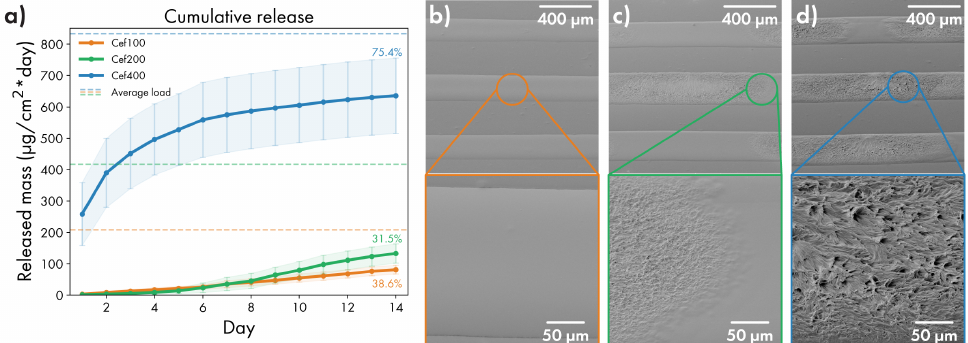
Figure 7. ( a ) Prolonged release profiles of Cefazolin from films prepared with various drug load (100/200/400 mg per 1 mL of PVA matrix). ( b – d ) SEM image for the surface of uncoated drug strips for Cef100 , Cef200 and Cef400 samples,